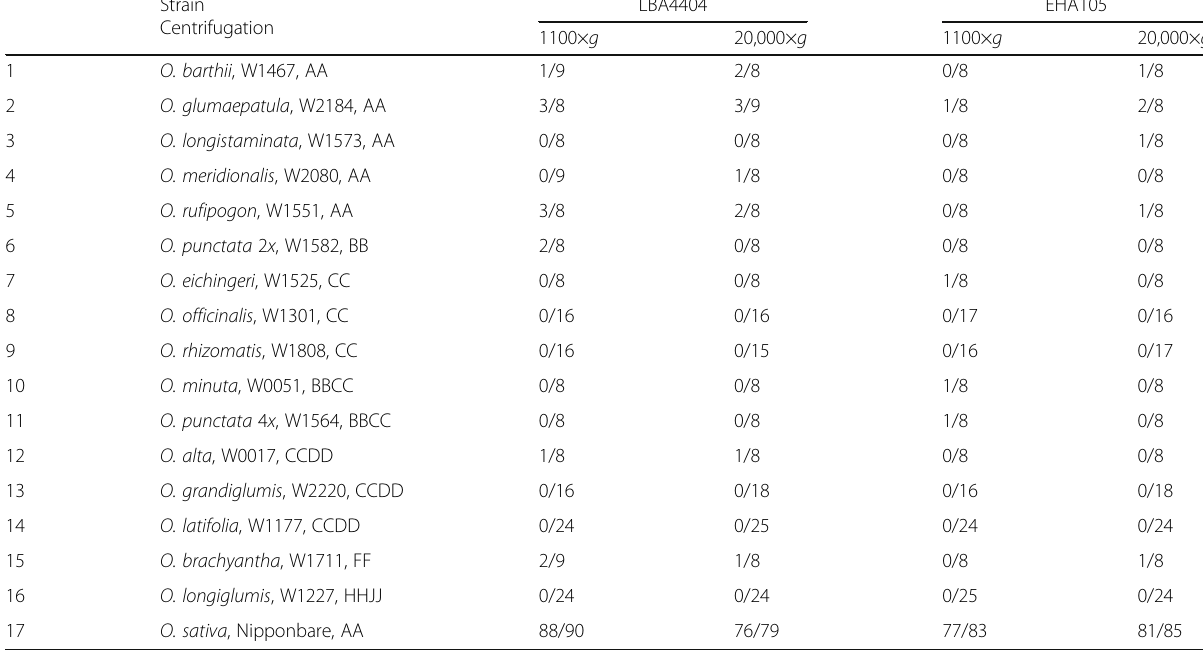
Table 4 Efficiency of Agrobacterium infection of calli induced from immature embryos of 16 wild Oryza